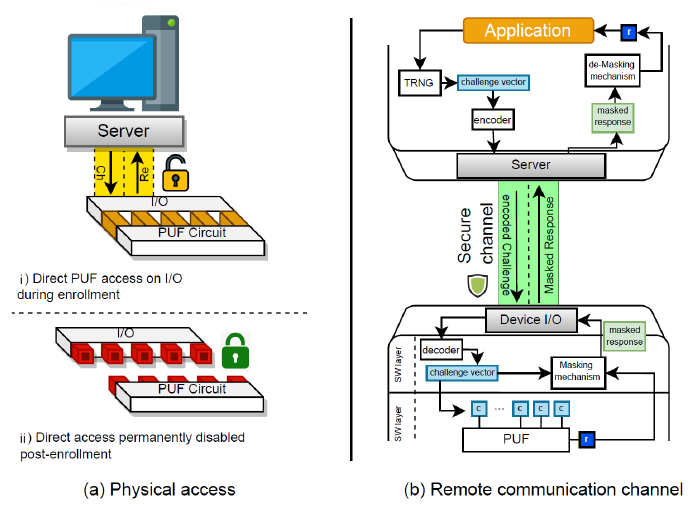
Figure 2. Secure sketches for PUF-based Computing. Here, ( a ) demonstrates the permanently disabling physical access to PUF after enrollment. ( b ) demonstrates a sketch for securing exposed CRP by encoding the challenge on the server side and masking the response from the PUF